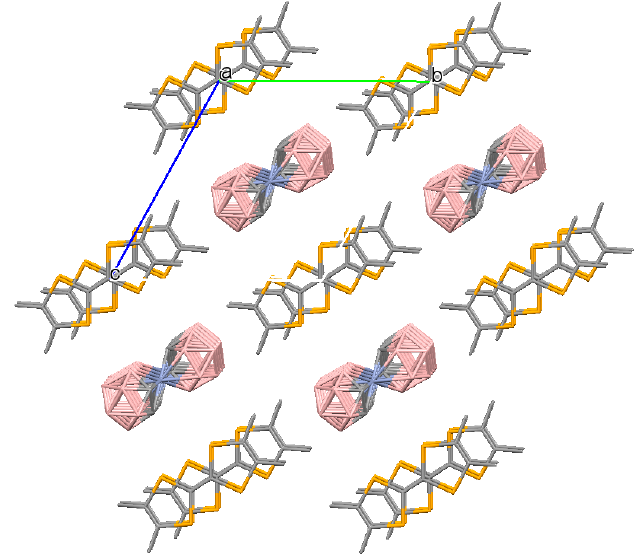
Figure 7. Crystal packing fragment of ( 3 ). A view along the a axis. The unit cell is outlined. H atoms